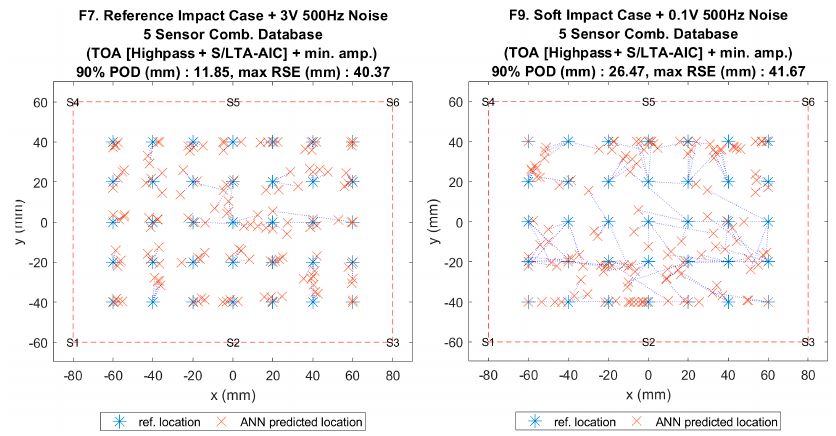
Figure 13. Visualisation of impact localisation for soft impacts (F8) using different input features: NSET extracted ToA (left) and S/LTA-AIC extracted ToA with normalized minimum amplitude (right).